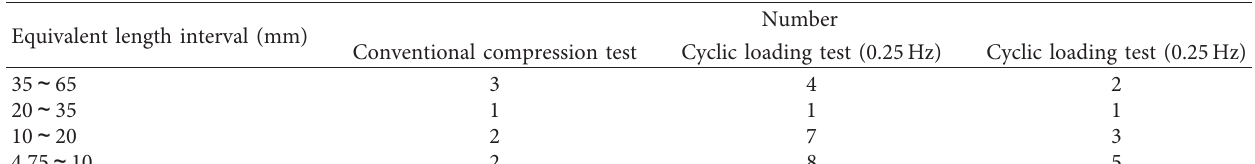
Table 7: Equivalent length interval and quantity under the confining pressure of 10MPa.